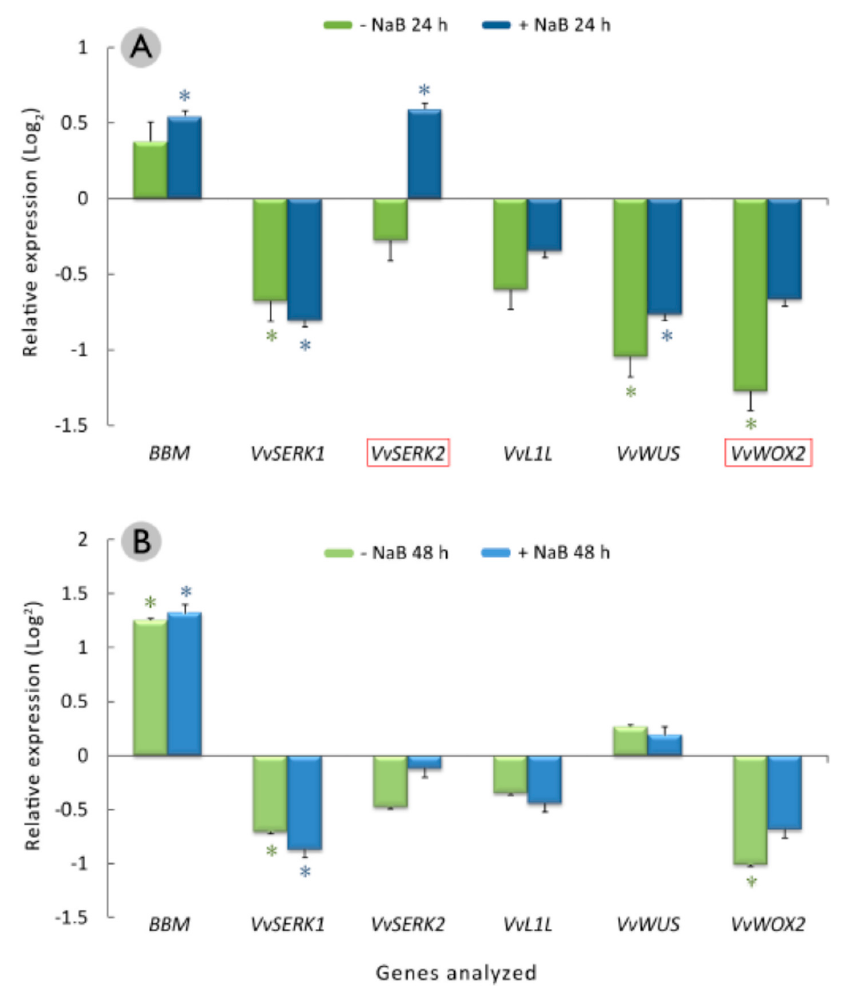
Figure 5. Relative expression of genes related to somatic embryogenesis in grapevine cv. Mencía cotyledonary somatic embryos that were cultured in the induction medium supplemented with 0.5 mM NaB (blue) or without NaB (green) for 24 ( A ) and 48 ( B ) h. The mean values of two independent experiments ± standard errors are shown. Asterisks indicate statistically significant differences ( p < 0.05) between the calibrator group (cotyledonary somatic embryos used as starting material) and the analyzed group, while red squares framing genes indicate statistically significant differences ( p < 0.05) between the NaB and no NaB treatments.